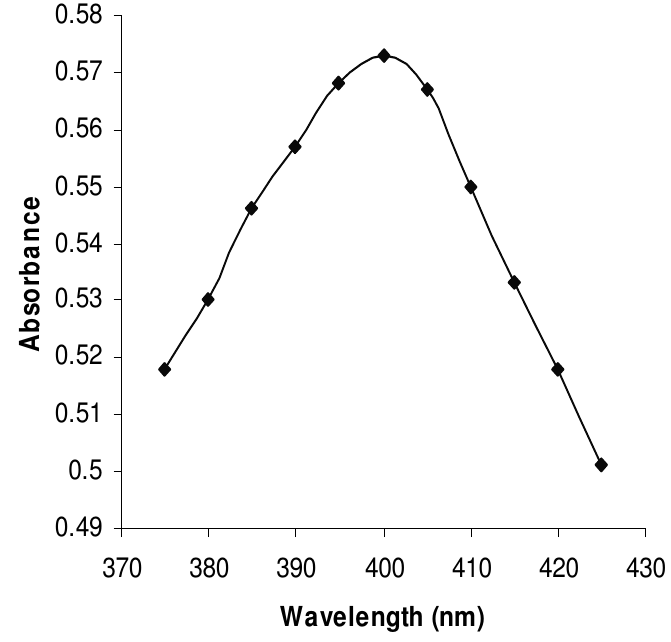
Figure 4. Absorption spectrum of reaction product between alfuzosin (Final concentration 50 µ g/mL) and PBQ